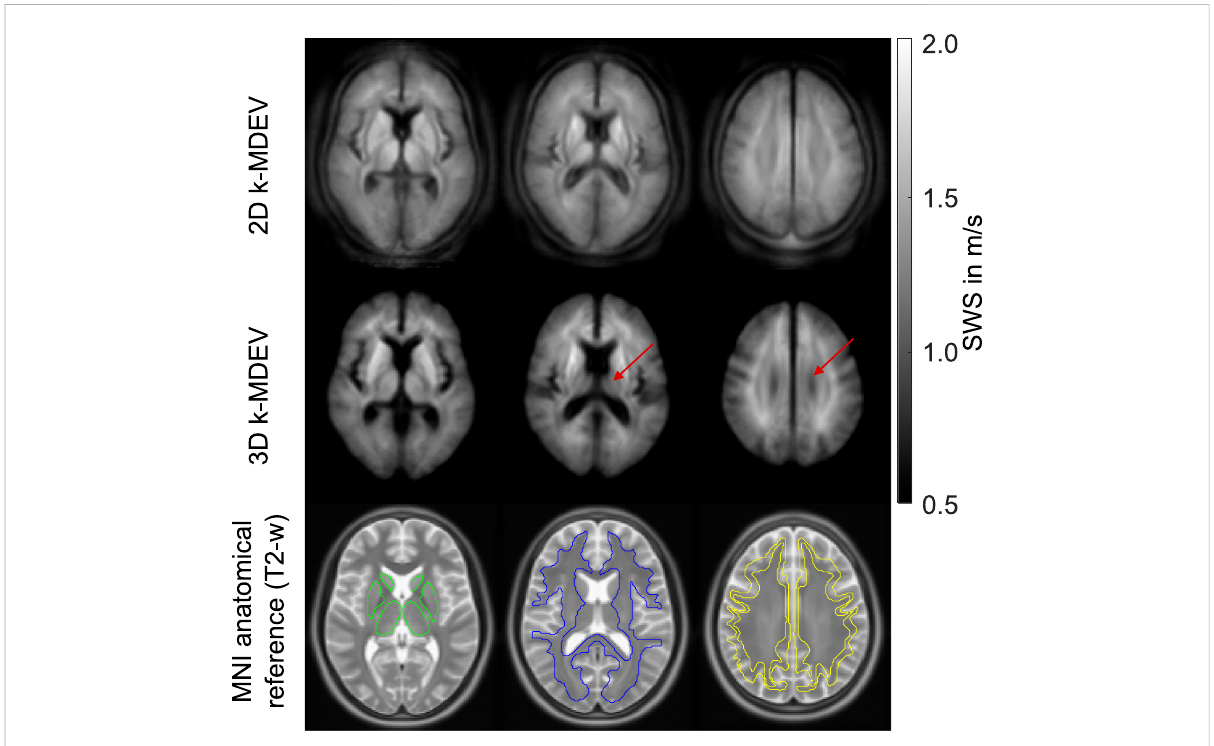
FIGURE 2 Averaged SWS maps from 2D and 3D k -MDEV inversions normalized to MNI space in three representative slices. Red arrow indicates where boundary artifacts from adjacent slices become visible in 3D reconstruction. Anatomical reference images (ICBM152 template) are shown superimposed with atlas regions for deep gray matter (green), white matter (blue), and cortical gray matter (yellow).